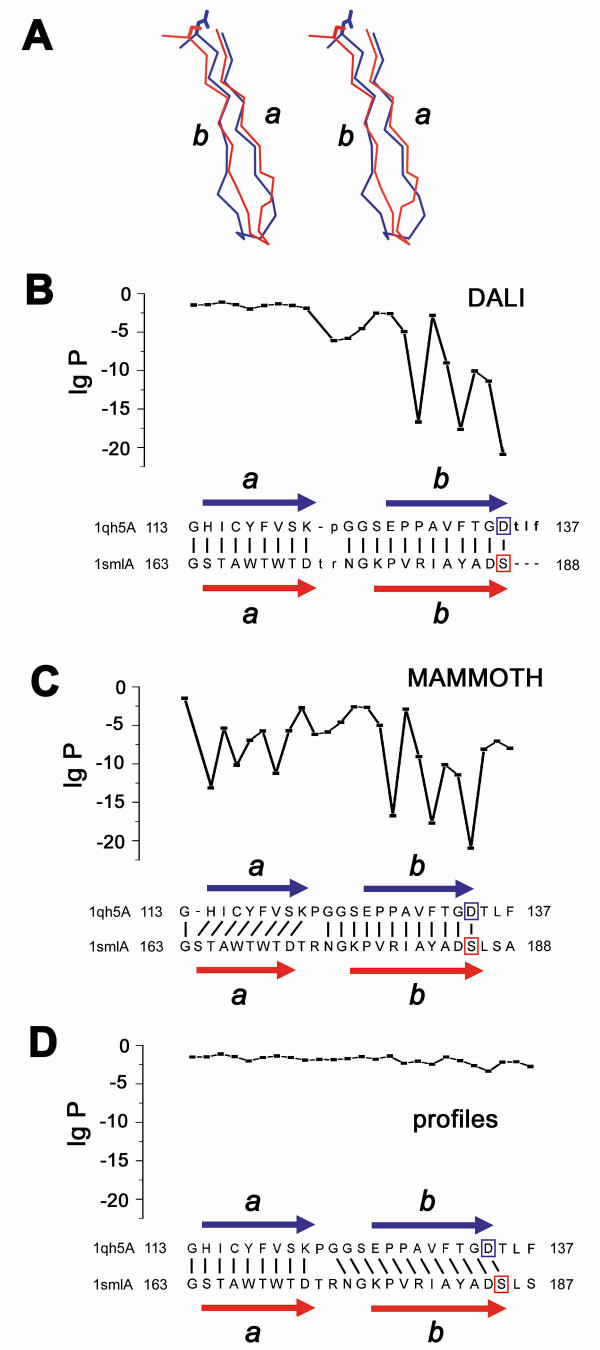
Two sources of discrepancies between structure-based and profile-based position similarities: misalignment and structural or functional specificity. A. Manual alignment of fragments of human glyoxalase II (PDB ID 1qh5A) and bacterial penicillinase (PDB ID 1sml). Strands b are shifted by one register, so that structurally similar residues correspond to different sequence positions. In these strands, sidechains are shown for the residues involved in Zn binding (D134 and S 185, respectively). (B-D) Alignments produced for these fragments by different methods, with corresponding positional P-values. Secondary structure elements (beta stands a and b) are shown with arrows. Structurally equivalent residues are connected with lines, residues involved in Zn binding are boxed. B. DALI correctly reproduces structural alignment of strands a, resulting in relatively high positional P-values in this region. Alignment of strands b is also structurally correct, but their shift in the two structures results in discrepancy between structural alignment and profile content, as reflected by low P-values. C. MAMMOTH misaligns strands a by one register. Low P-values indicate significant profile dissimilarity between aligned positions in both regions a and b. D. Profile-based alignment is in good accord with profile content, as shown by higher P-values for regions a and b. Note that alignment in region b differs from the structure-based alignment shown in B.